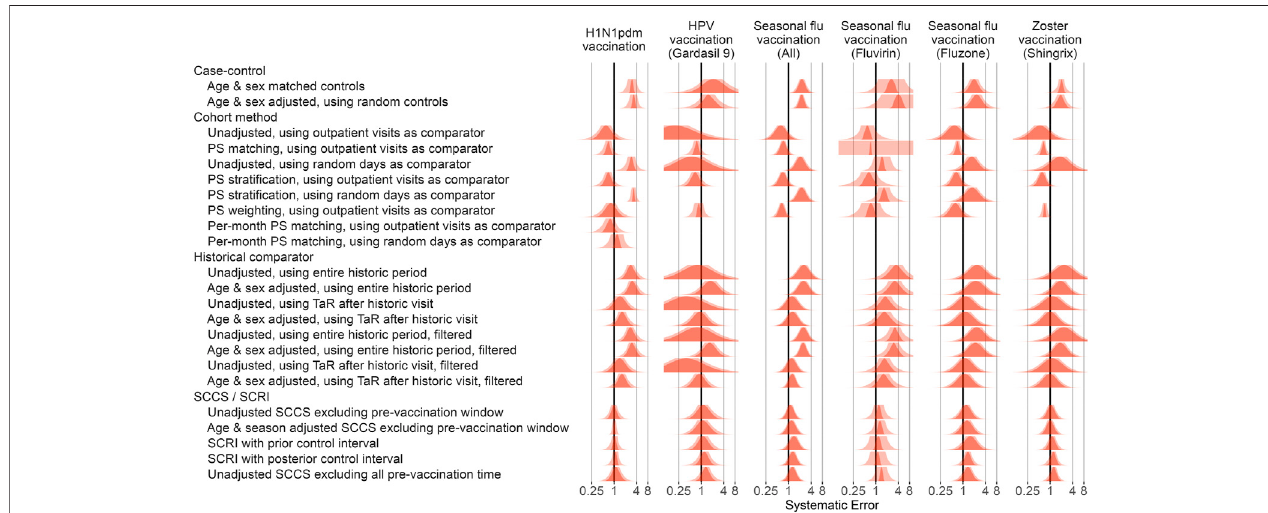
FIGURE 3 | Fitted systematic error distributions. For each method variation and vaccine group, the systematic error distribution fi tted on the negative control estimates in the Optum EHR database are shown. The red area indicates the maximum likelihood estimates of the distribution parameters. The pink area indicates the 95% credible interval. HPV = Human papillomavirus, PS = Propensity Score, SCCS = Self-Controlled Case Series, SCRI = Self-Controlled Risk Interval, TaR = Time-at-